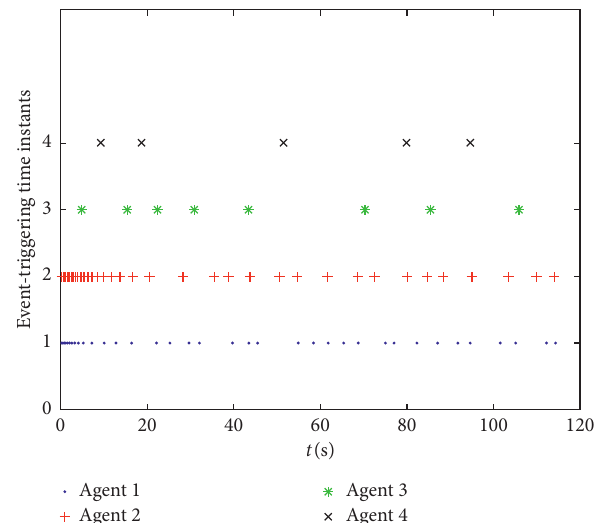
Figure 6: Event-triggering time instants of each agent when τ � 0.